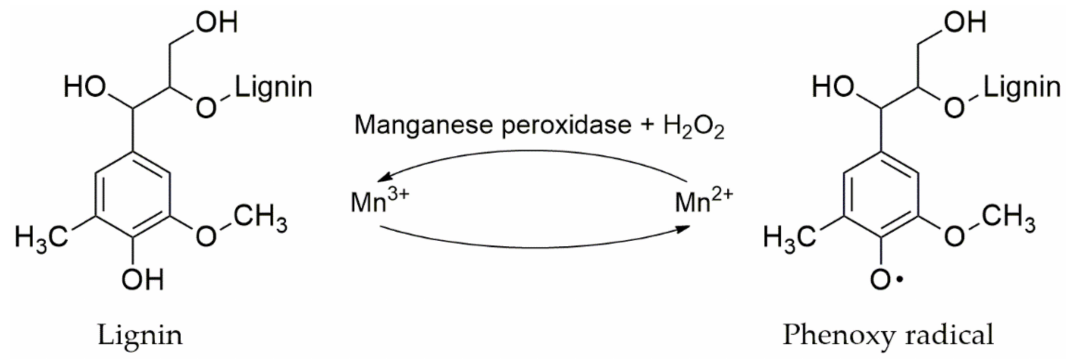
Figure 11. Lignin depolymerisation with manganese peroxidase